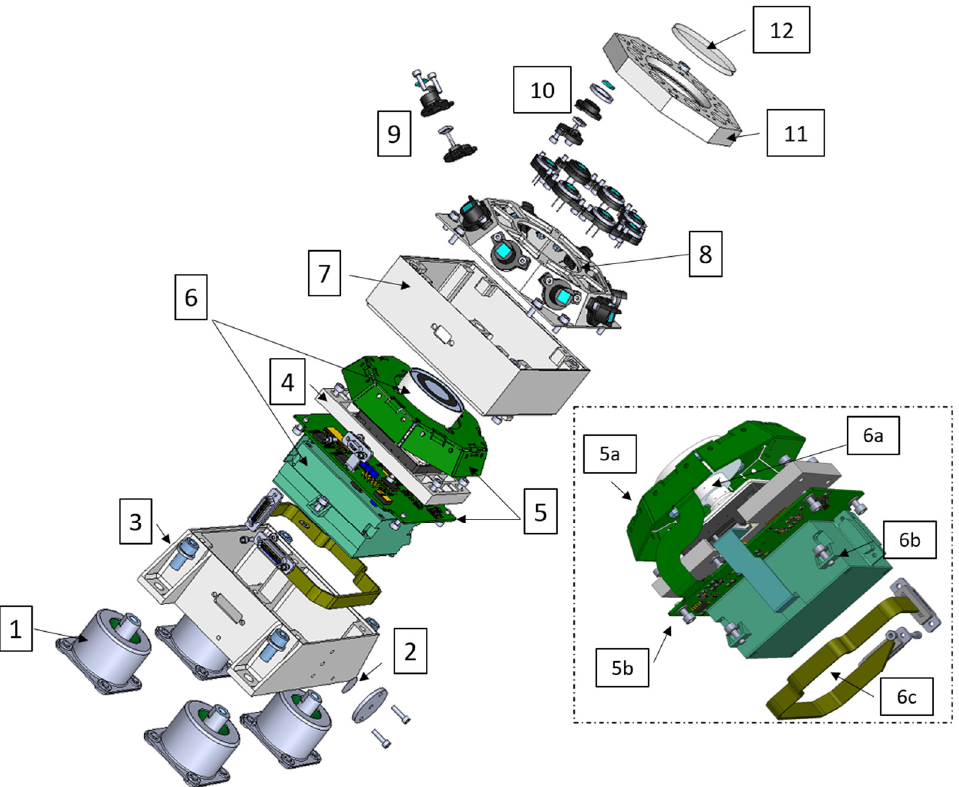
Figure 3. RDS exploded view: (1) shock supressors, (2) HEPA filter, (3) lower-level structure, (4) camera base plate, (5) discrete photodetector PCB, (6) camera subassemblie, (7) intermediate-level structure, (8) upper level structure, (9) lateral optical channel subassemblie, (10) top channel subassemblie, (11) octogonal top cover, and (12) sapphire window. The rectangle includes a detail (reversed view) of the tight integration between RDS-DP and SkyCam sub-assemblies: (5a) semi-rigid RDS-DP optical head PCB, (5b) semi-rigid RDS-DP processing electronics PCB, (6a) Skycam optical head, (6b) Skycam electronic box, and (6c) Skycam I/F internal cable.